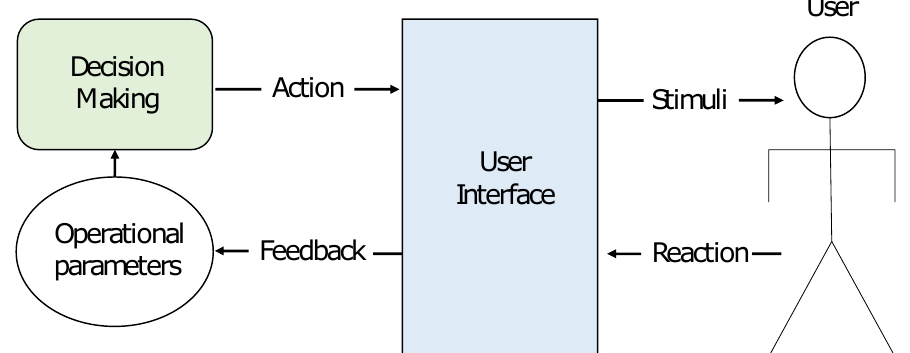
Figure 6. General schematic of a user-adaptive system without the user’s model. The system’s behaviors are direct reactions to the user’s feedback, and decisions are made without the user’s previous knowledge.